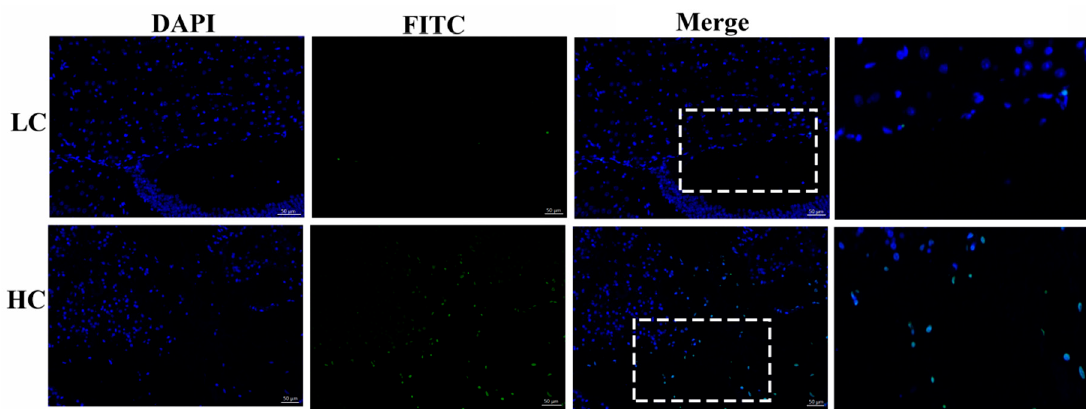
Figure 1. Determination of apoptotic cells by the tunnel assay. The HC (high-concentrate) group showed a significant amount of positive apoptotic cells (white arrows) in contrast to the LC (low-concentrate) group. The nucleus was made blue by labeling with DAPI and the positive apoptosis cells are green (FITC) , white rectangular selected area shows an enlarged area. The images were taken at a 50 μ m scale bar.